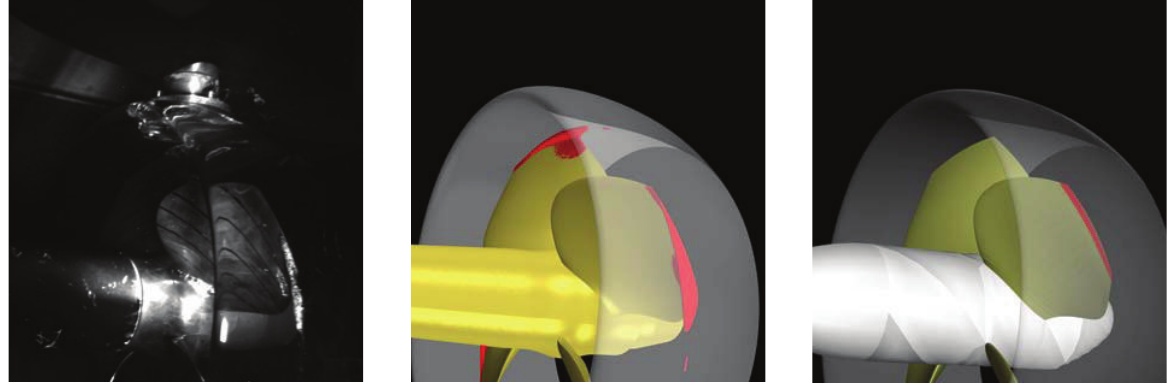
Figure 16: Observed and predicted (RANS and panel method) cavity extension. Design thrust coe ffi cient at 80% of design cavitation index.